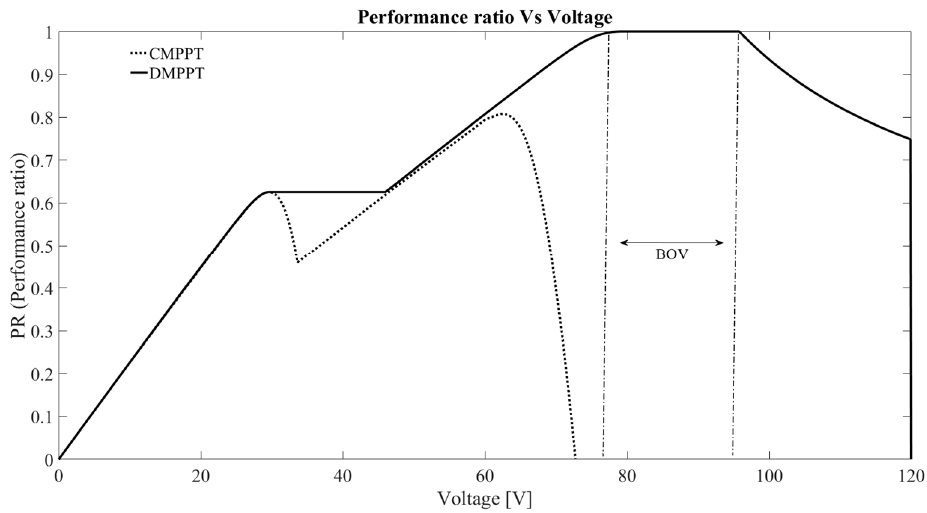
Figure 4. Performance ratio vs. voltage of series connection of two Boost based photovoltaic units (PVUs) ( V dsmax = 60 V, MD = 0.4 ).